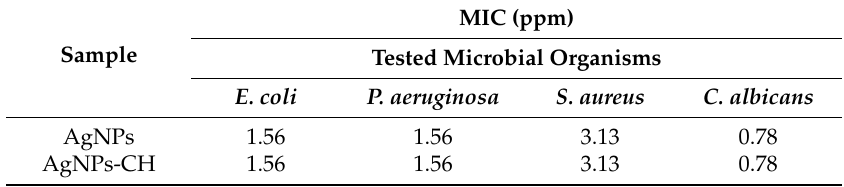
Table 1. The MIC of bare AgNPs and AgNPs stabilized in 1% HMW chitosan